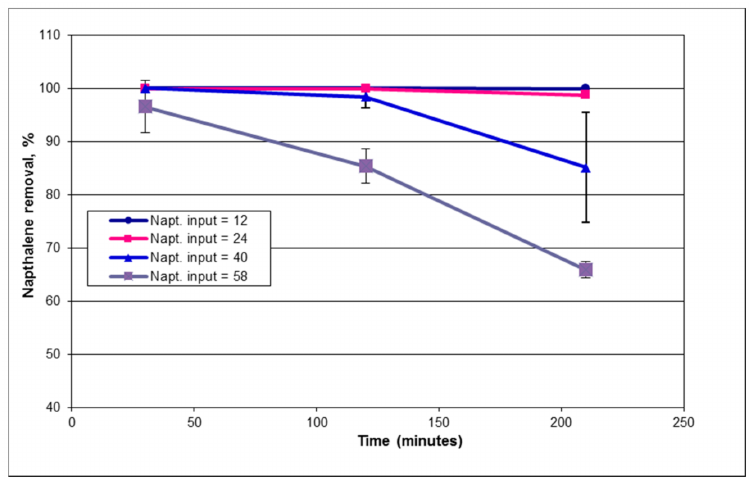
Figure 9. Effect of naphthalene loading on its removal efficiency (T—750 ◦ C, S/C—5, GHSV— 12,800 h − 1 , catalyst—7.5% Ni-montmorillonite).